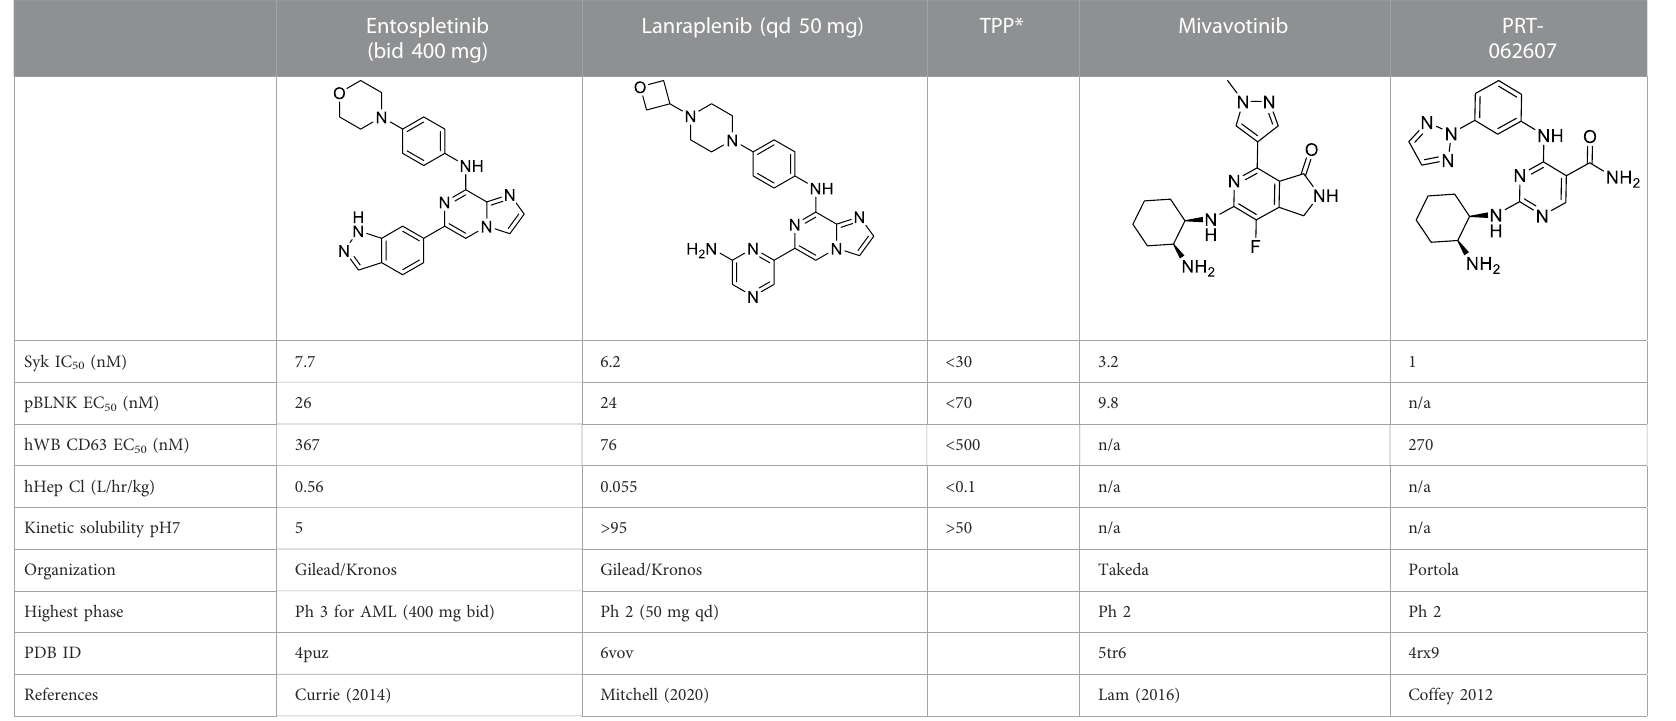
TABLE 1 Clinical Stage SYK inhibitors used in this study.